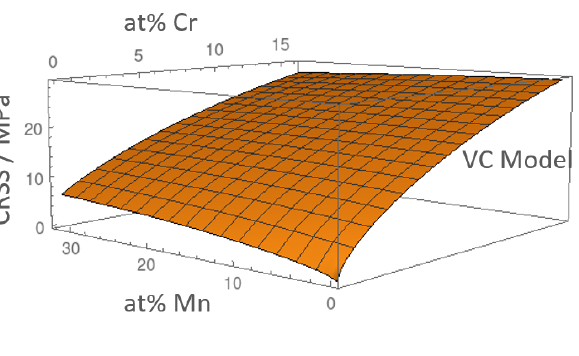
Figure 7. Solid solution strengthening in Fe for separate Cr and Mn alloying.